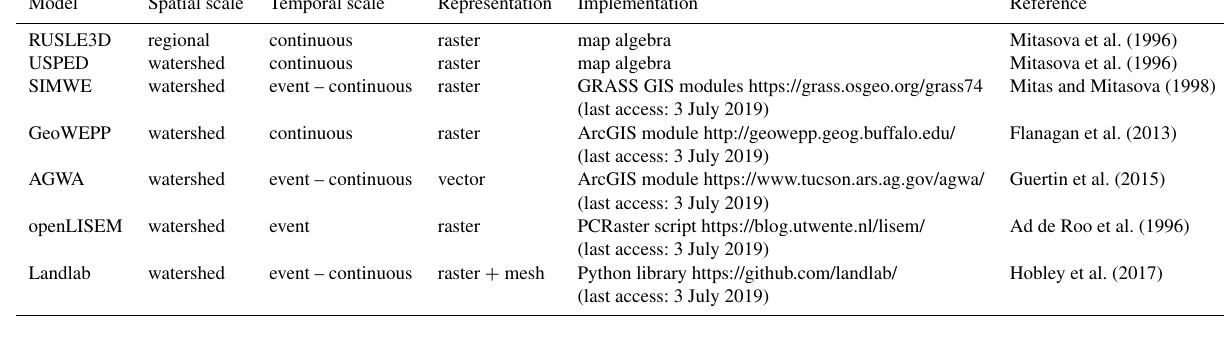
Table 1. Examples of geospatial soil erosion models.